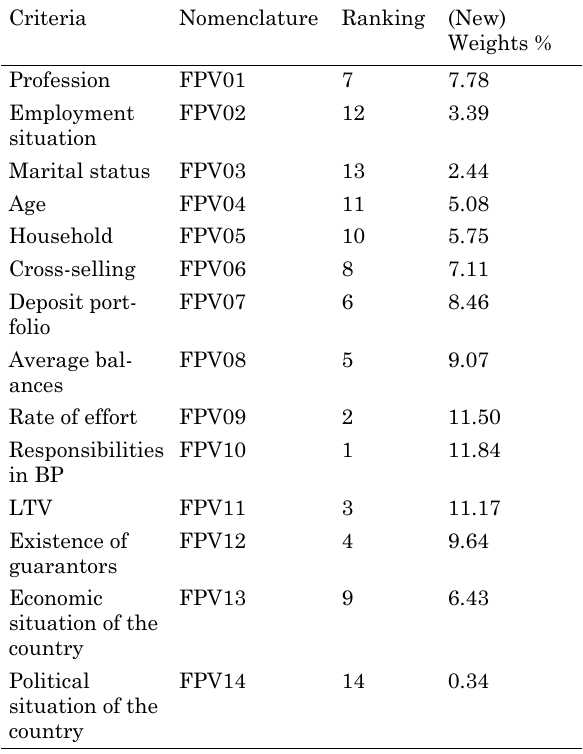
Table 4. Criteria ranking and “MACBETH”